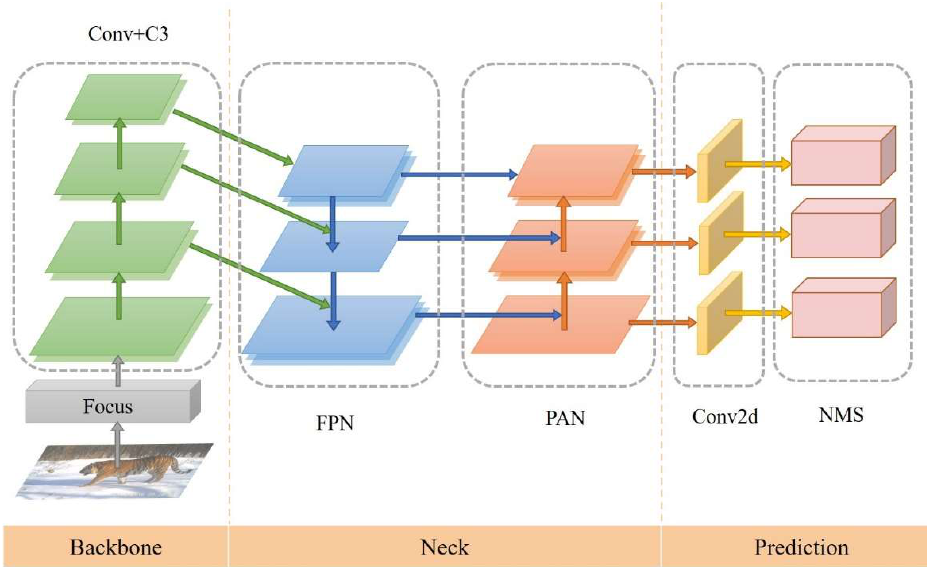
Figure 2. YOLOv5 structure diagram. Conv is convolution; C3 is improved from the Cross Stage Partial Network (CSP Net); Conv2d is two-dimensional convolution.